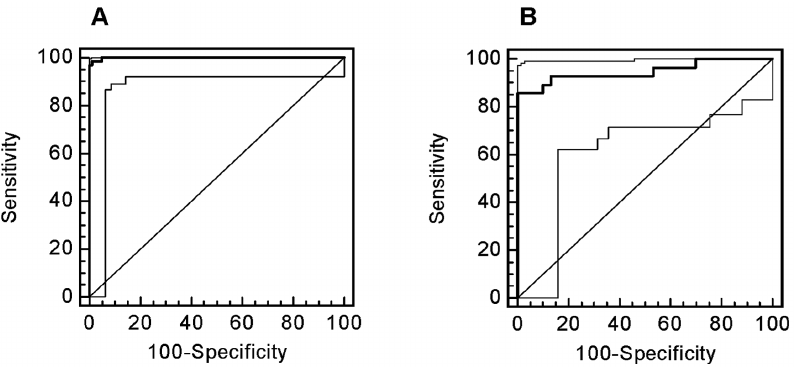
Figure 7. ROC curves for classification of the patient collectives with the ‘DN type 2’ pattern. ROC analysis for CKD diagnosis of the training set ( A ) and the test set ( B ).